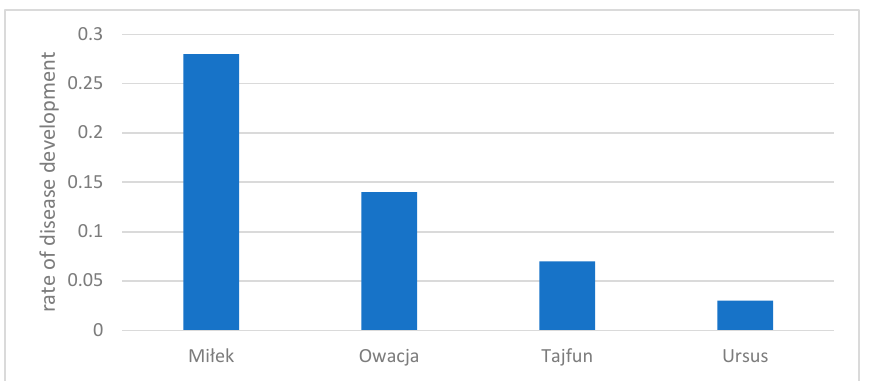
Figure 8. Rate of late blight development depending on cultivars resistance to P. infestans (Jadwisin 2008–2010).